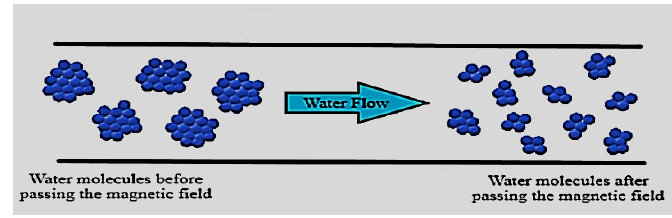
Figure 1. Water molecules after magnetization [29].